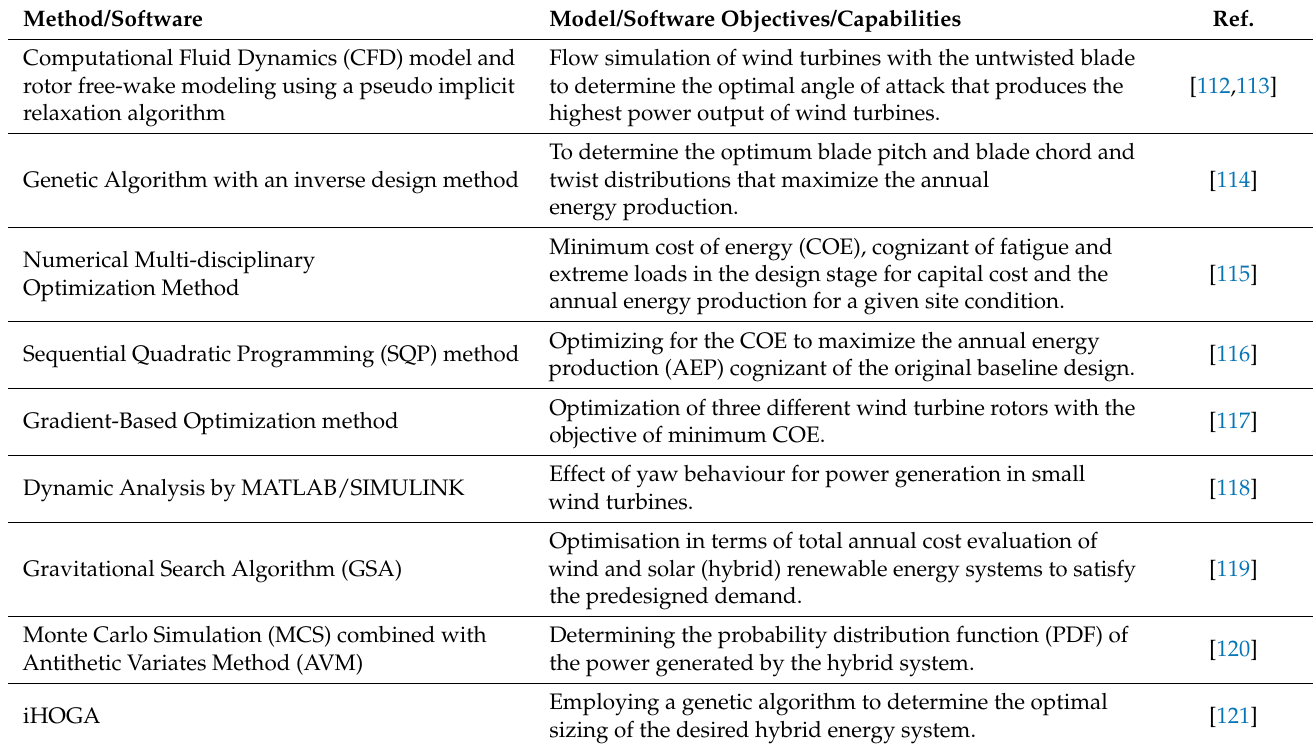
Table 4. Summary of optimization